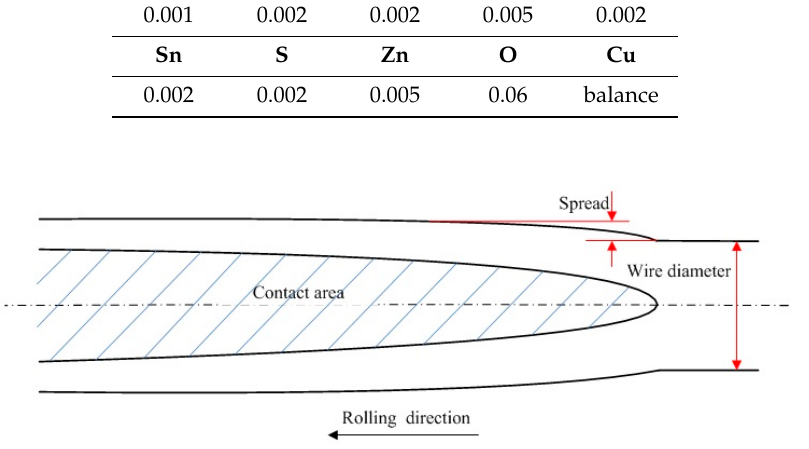
Figure 2. Schematic of the deformed wire (from above).